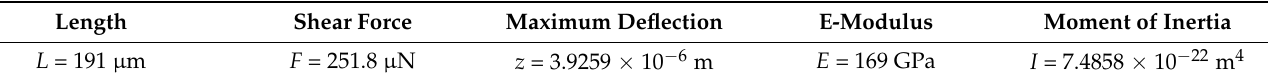
Table 1. The mechanical properties and bending data values of the AFM cantilever. Length Shear Force